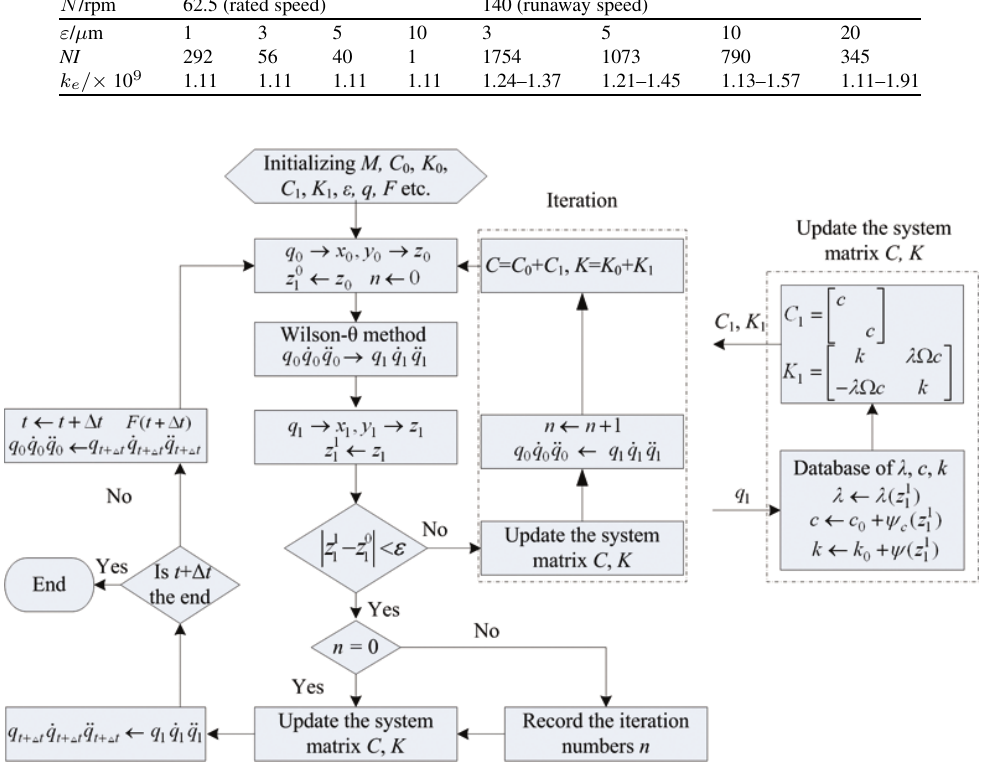
Fig. 5. Flow chart of the algorithm. The left arrows ← in the box denotes assigning a value to the left and the right arrows → denotes calculating from the left. x , y are the two displacement dofs in q and z =